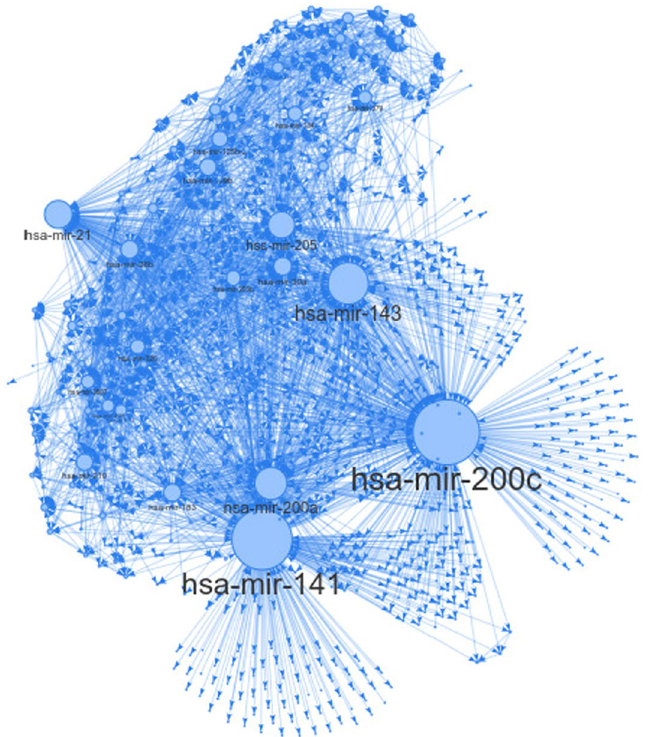
Fig. 5 Example network generated by the hybrid oMII algorithm. Nodes and text are sized relative to the out degree of the node. The nodes with largest out degree have previously been connected with breast